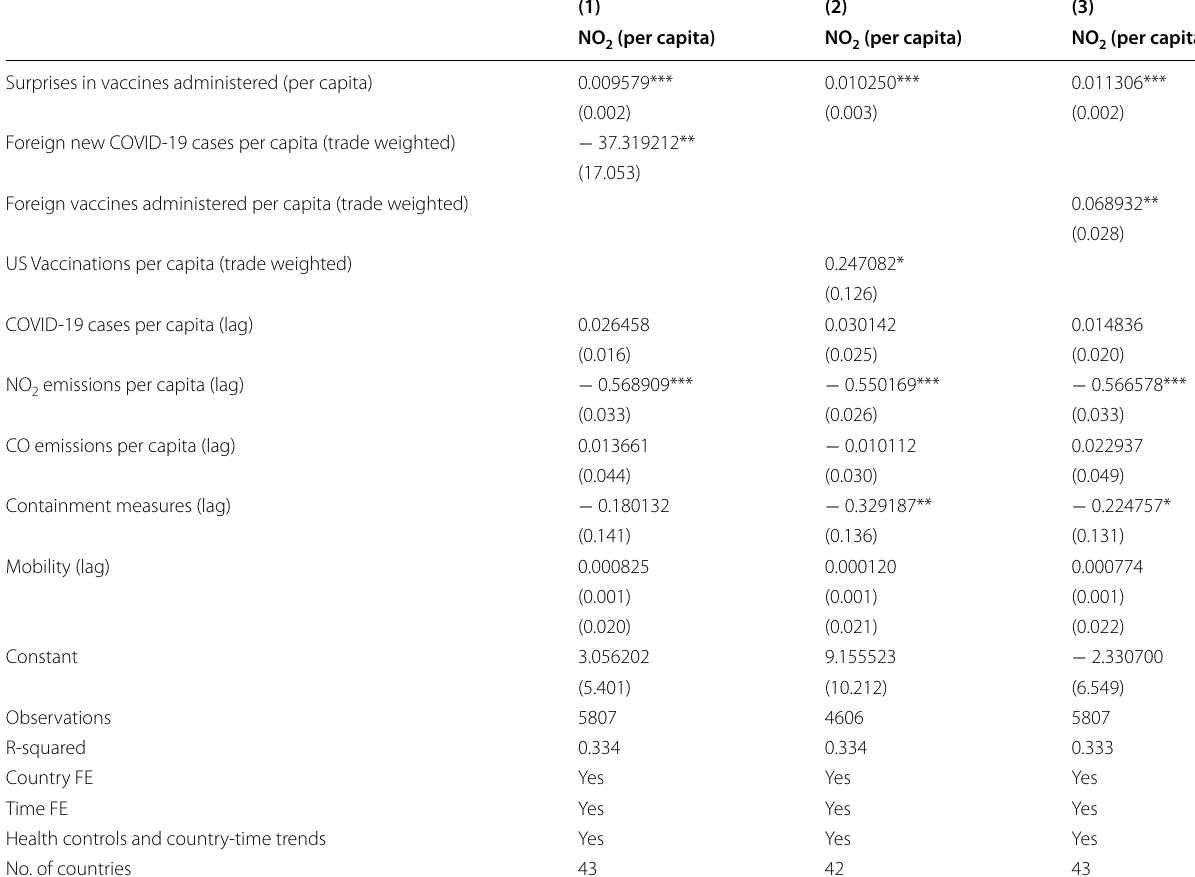
Table 6 Effects of foreign new COVID-19 cases and vaccines on economic